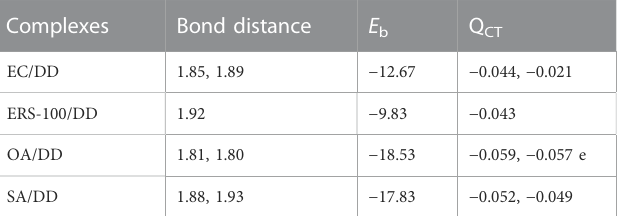
TABLE 5 Bond distances (Å), binding energy ( E b kcal/mol) and charge transferred (Q CT e) for the different complexes of DD with polymers obtained though DFT simulations.